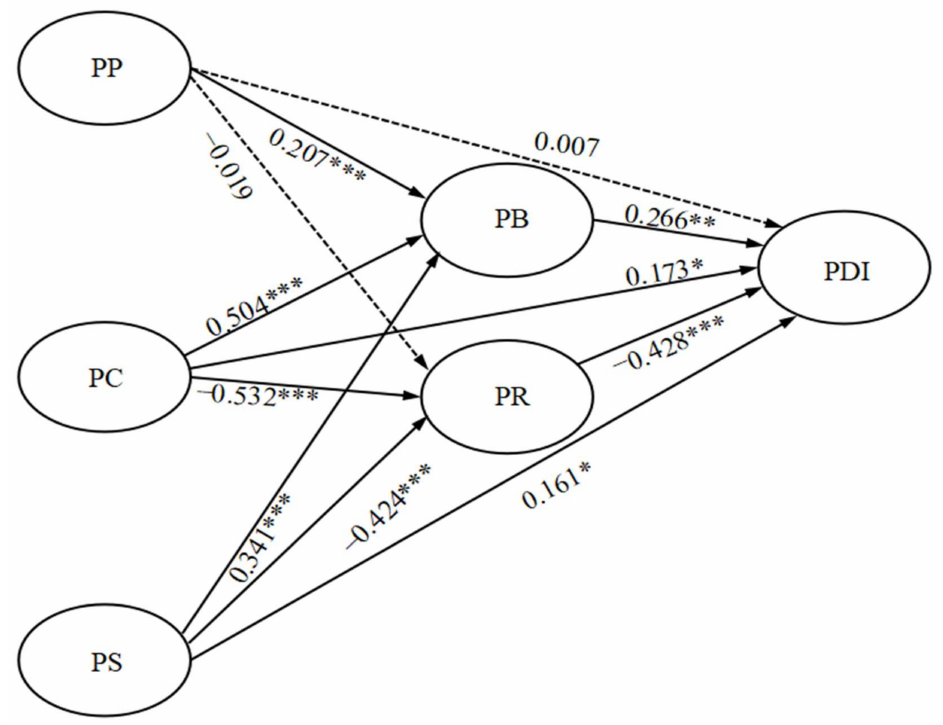
Figure 2. Measurement model. (Remark: * means p < 0.05; ** means p < 0.01; *** means p <